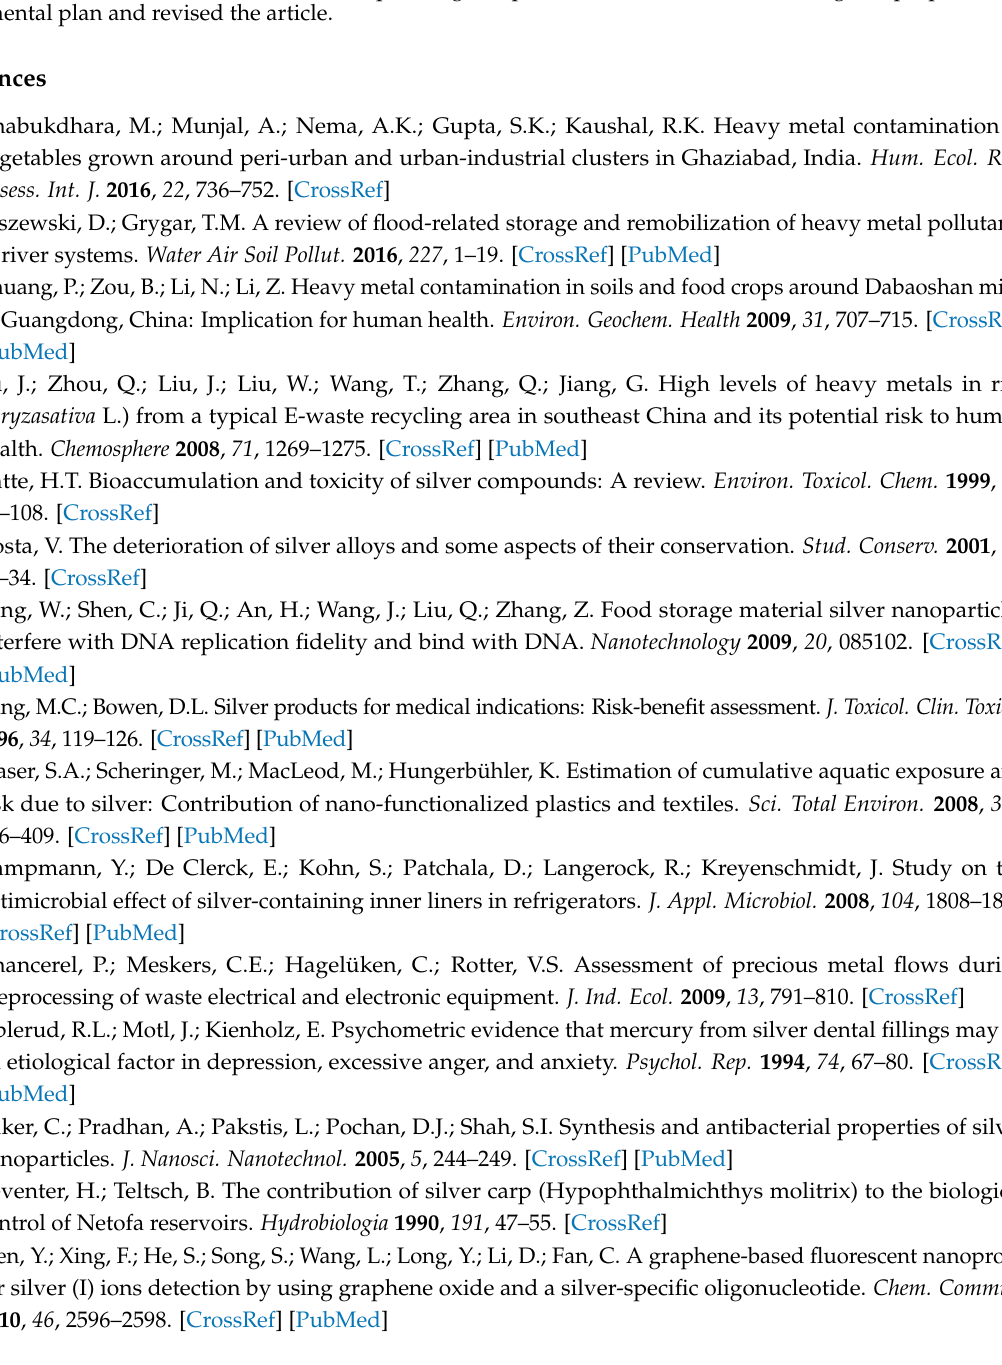
Figure S6: The resistance of the biosensor with the different Ag(I) concentrations (100 pM, 100 nM, 100 µ